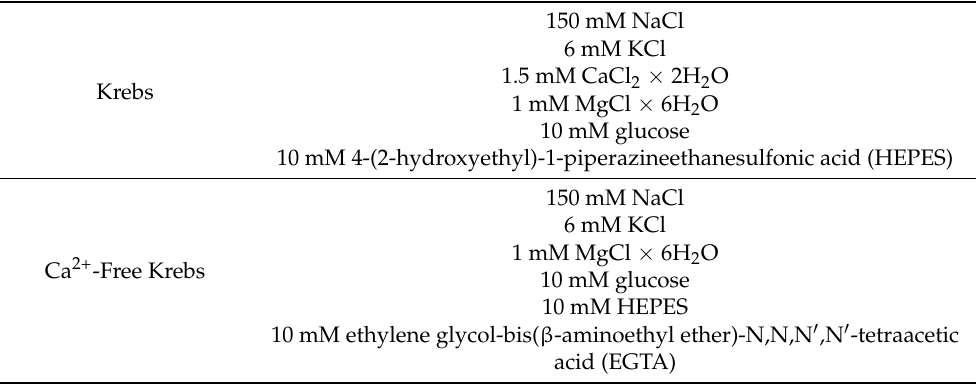
Table 2. Composition of the solutions used in the